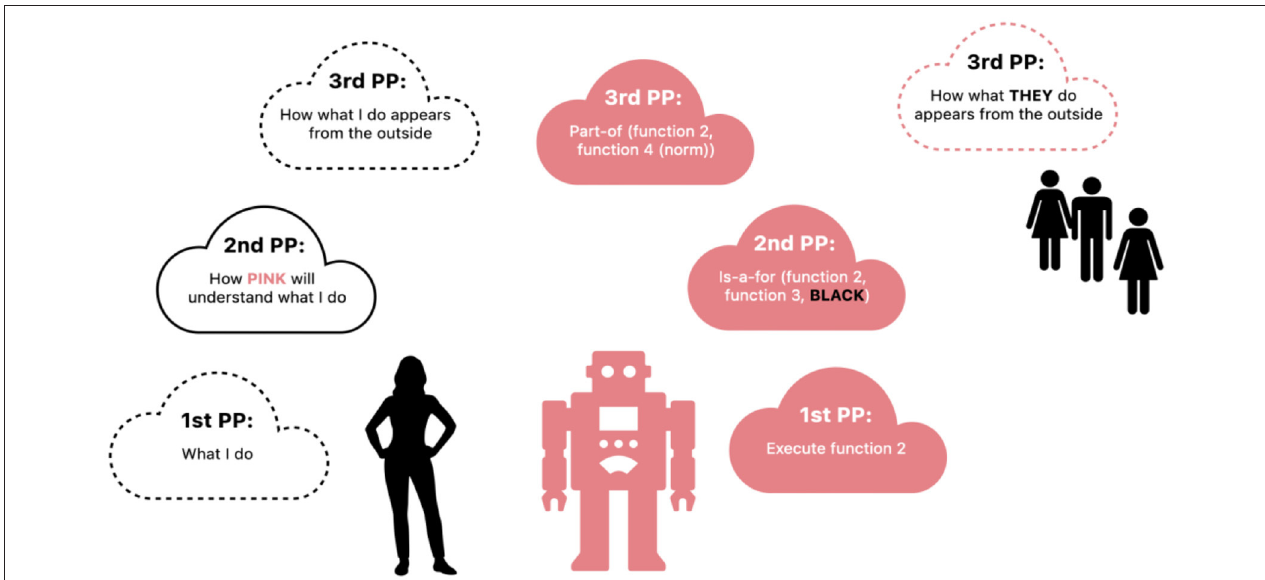
FIGURE 1 | The modified second-person perspective in asymmetrical social interactions, adapted by Eli McGraw and Jacqueline McGraw from Seibt, Vestergaard and Damholdt 2020, with permission. dynamic systems in social interaction. This joins historical